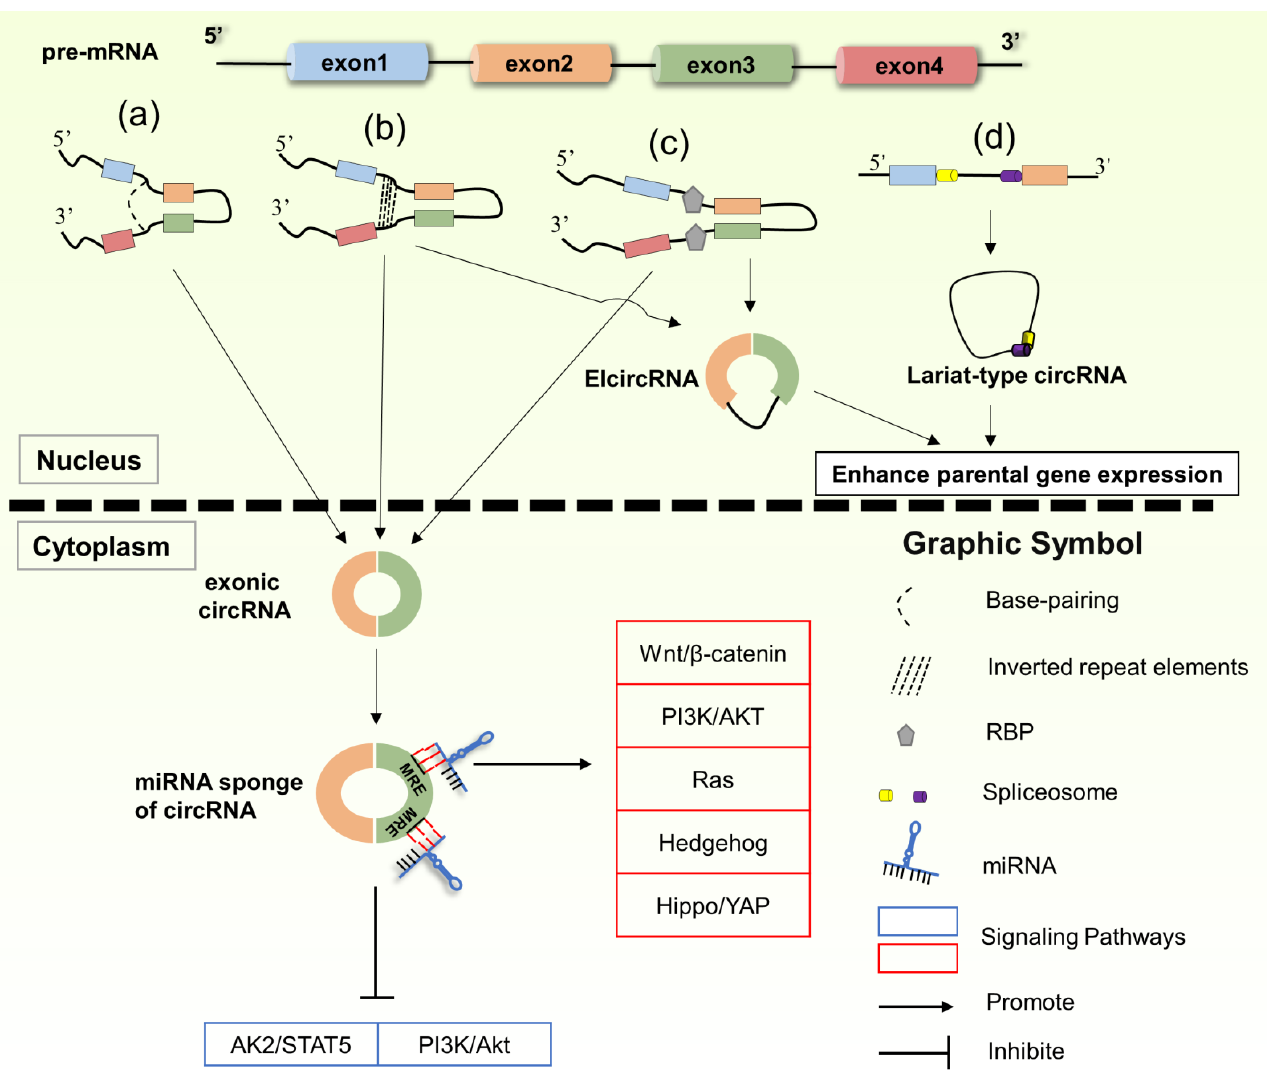
Figure 1. The formation of circRNA and its downstream target signal pathway in BC or CRC. ( a ) exonic circRNA; ( b ) circRNA combined with introns and exons, also known as elcircRNA; ( c ) circRNA formation is regulated by RNA-binding proteins (RBPs); ( d ) lariat-type circRNA composed of introns. Abbreviations: MRE (miRNA response element).